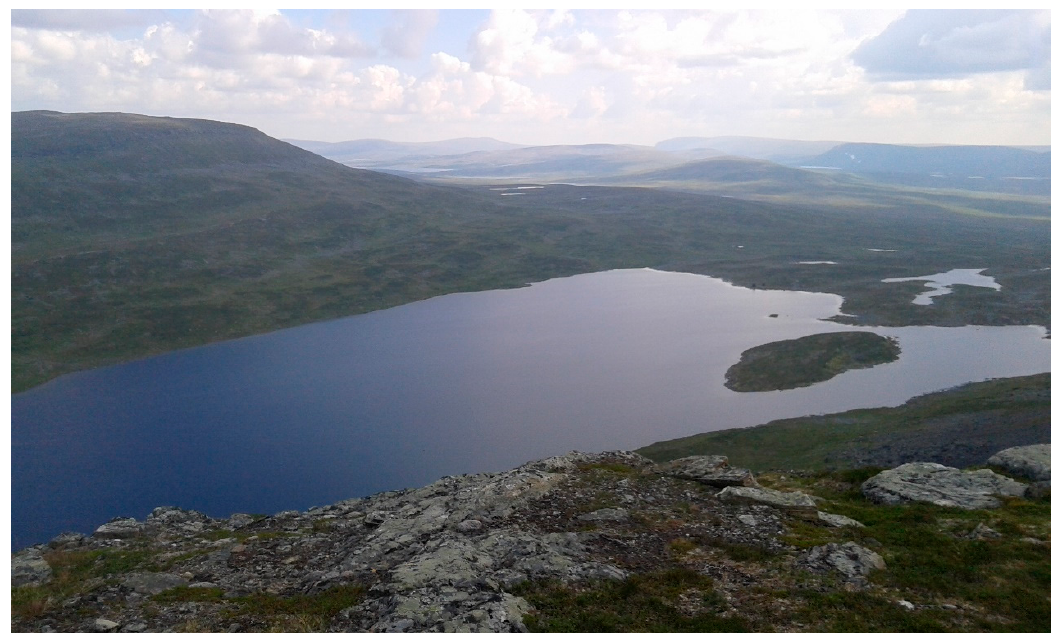
Figure 2. View from the south of Lake Saana to Mount Saana.